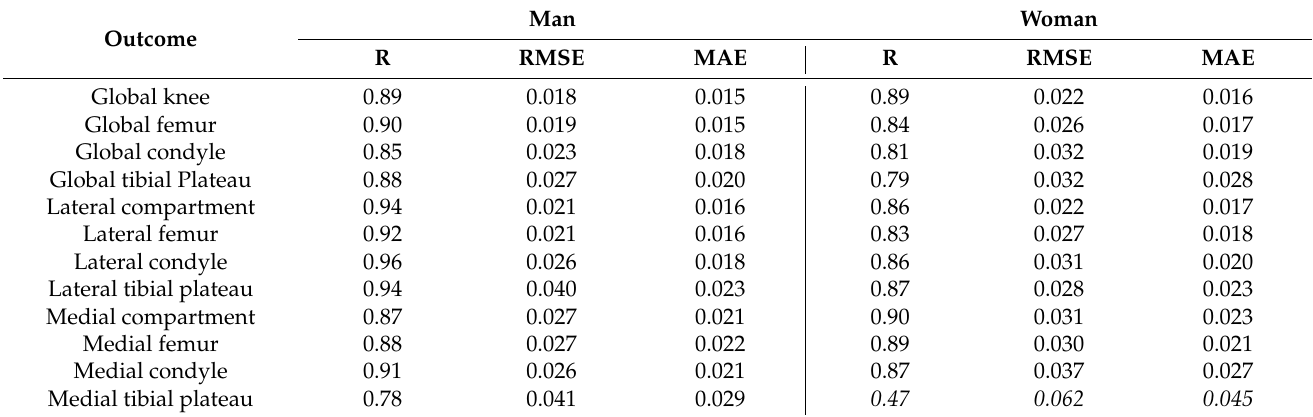
Table 10. Validation of the M20-13-6 model in the prediction of cartilage volume loss at one year in 12 cartilage regions using five bone curvature regions at the